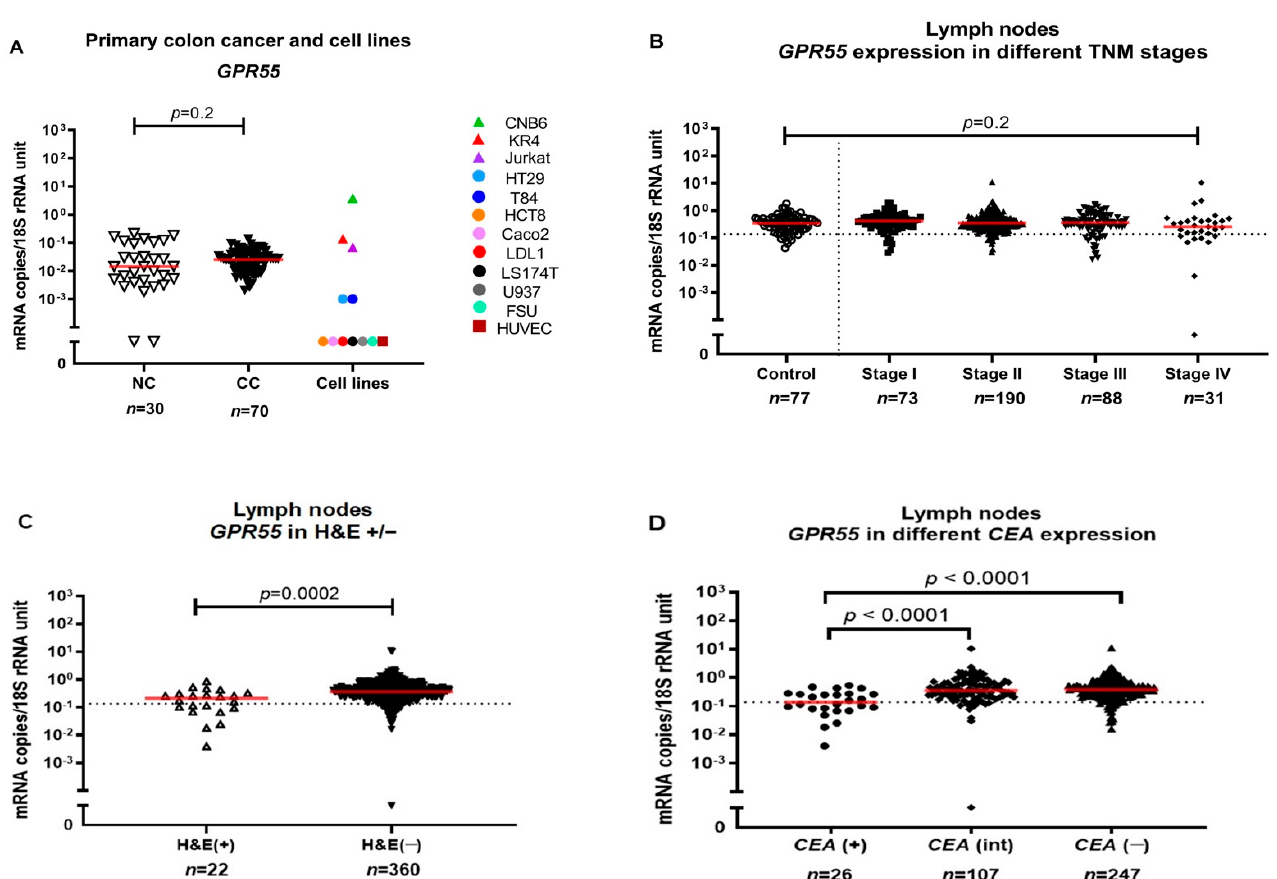
Figure 1. ( A ) GPR55 mRNA expression levels in resected normal colon tissues (NC), primary colon cancer tissues (CC) and in a panel of colon cancer cell lines: DLD1, LS174T, HT29, T84, HCT8 and Caco2, primary foreskin fibroblast cells (FSU), an endothelial cell line (HUVEC), a T cell line (Jurkat), two B cell lines (CNB6 and KR4) and a monocyte cell line (U937). ( B ) GPR55 mRNA expression levels in lymph nodes from non-cancerous disease patients (Control) and from colon cancer patients of different TNM stages (Stage I–IV). ( C ) GPR55 mRNA expression levels in metastatic (H&E(+)) lymph nodes and non-metastatic (H&E( − )) lymph nodes. ( D ) GPR55 mRNA expression levels in lymph nodes from CC patients divided into three groups according to their CEA mRNA levels: CEA(+) = CEA mRNA levels >3.67 copies/18S rRNA unit; CEA(int) = intermediate CEA mRNA levels, that is, 0.013–3.67 copies/18S rRNA unit; and CEA( − ) = CEA mRNA levels <0.013 copies/18S rRNA unit. Red horizontal lines indicate median values. Dashed horizontal lines indicate clinical cutoff values of 0.1365 mRNA copies/18S rRNA unit for GPR55. n = number of lymph nodes. p -values were calculated by Kruskal–Wallis non-parametric ANOVA, followed by post hoc Dunn’s test for multiple comparisons in ( B , D ) and by two-tailed Mann–Whitney test for comparison between expression levels in ( A , C ).